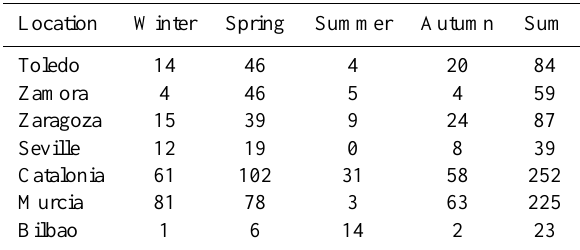
Table 3. Number of years with rogations for every season and for the whole year.